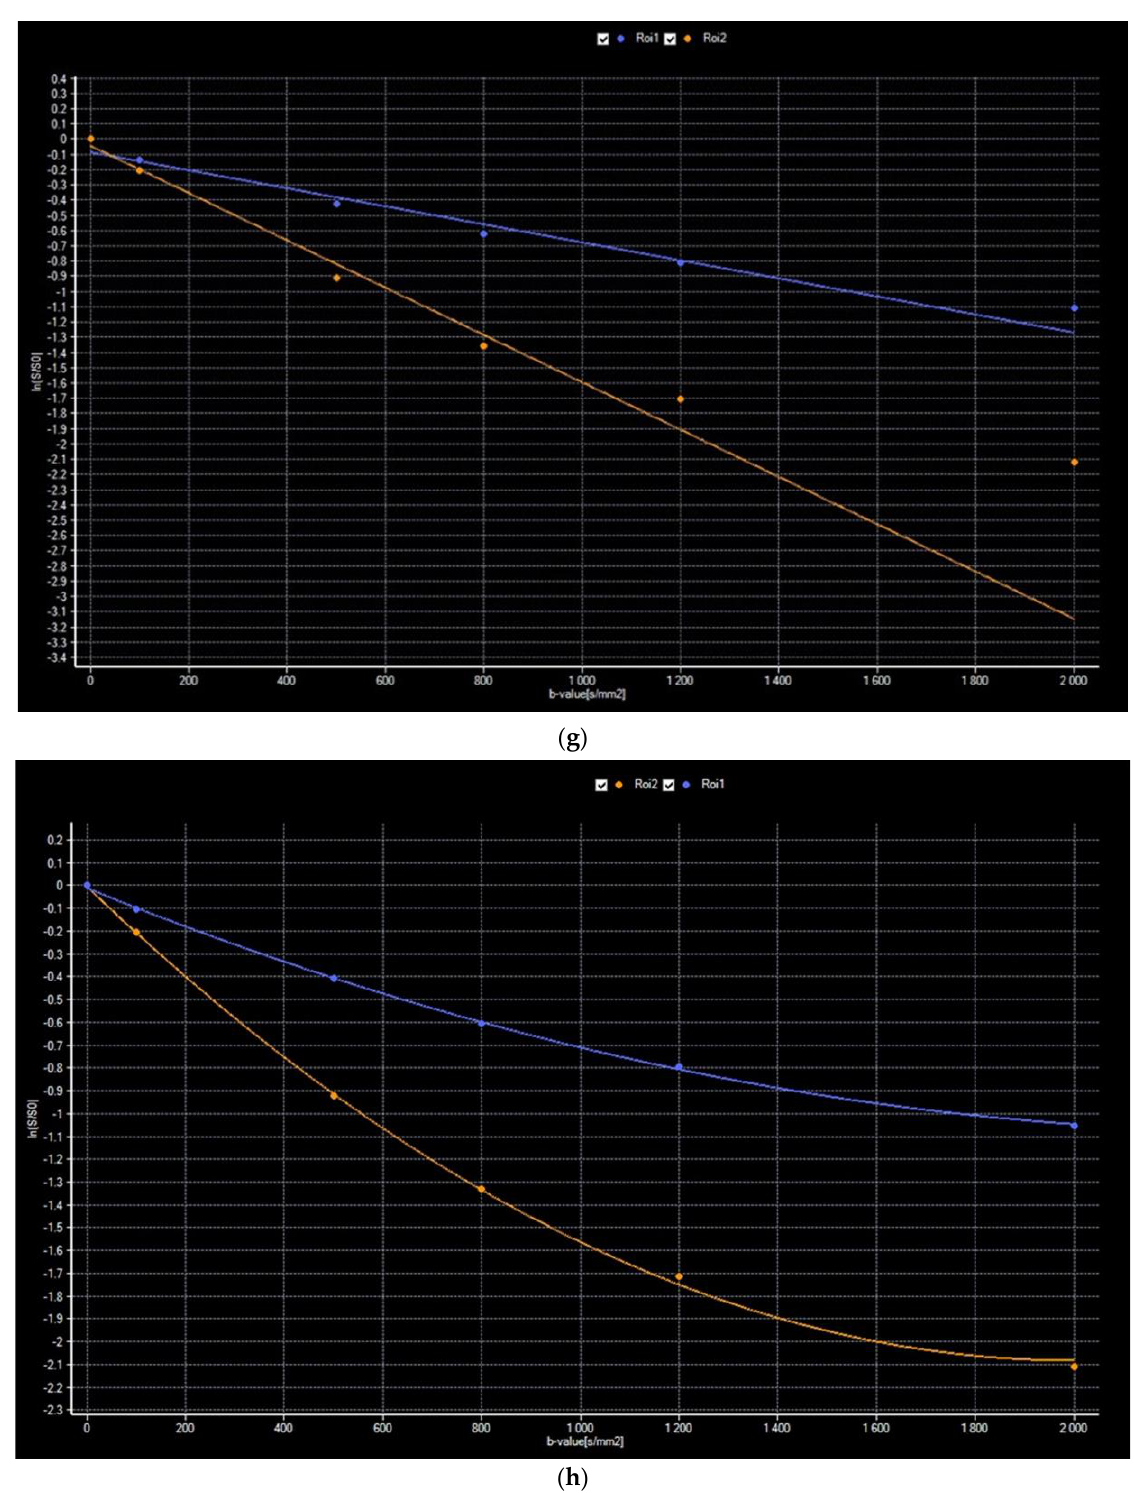
Figure 1. 62-year-old patient with PSA level 8 ng/mL and PIRADS 5 lesion located in left PZ, that after radical prostatectomy was assessed as acinar type prostate adenocarcinoma GS 4 + 3. Images of the prostate with GS 4 + 3 lesion in left PZ (ROI 1 — circled in blue) and control (ROI 2 — circled in orange) in benign prostatic tissue: ( a ) DWI at b-value 2000 s/mm 2 with high-intensity lesion in left PZ (ROI 1) and control ROI 2 in normal tissue ( b ) ADC map obtained with b-values 0 – 1200 s/mm 2 with corresponding low-intensity signal in lesion in left PZ (ROI 1) of 0.68 × 10 −3 mm 2 /s and control ROI 2 of 1.73 × 10 −3 mm 2 /s ( c ) Color-coded maps of D app and ( d ) kurtosis obtained with b-values 0 – 2000 s/mm 2 show D app of 0.88 × 10 −3 mm 2 /s and kurtosis of 1.40 in ROI 1 and D app of 2.18 × 10 −3 mm 2 /s